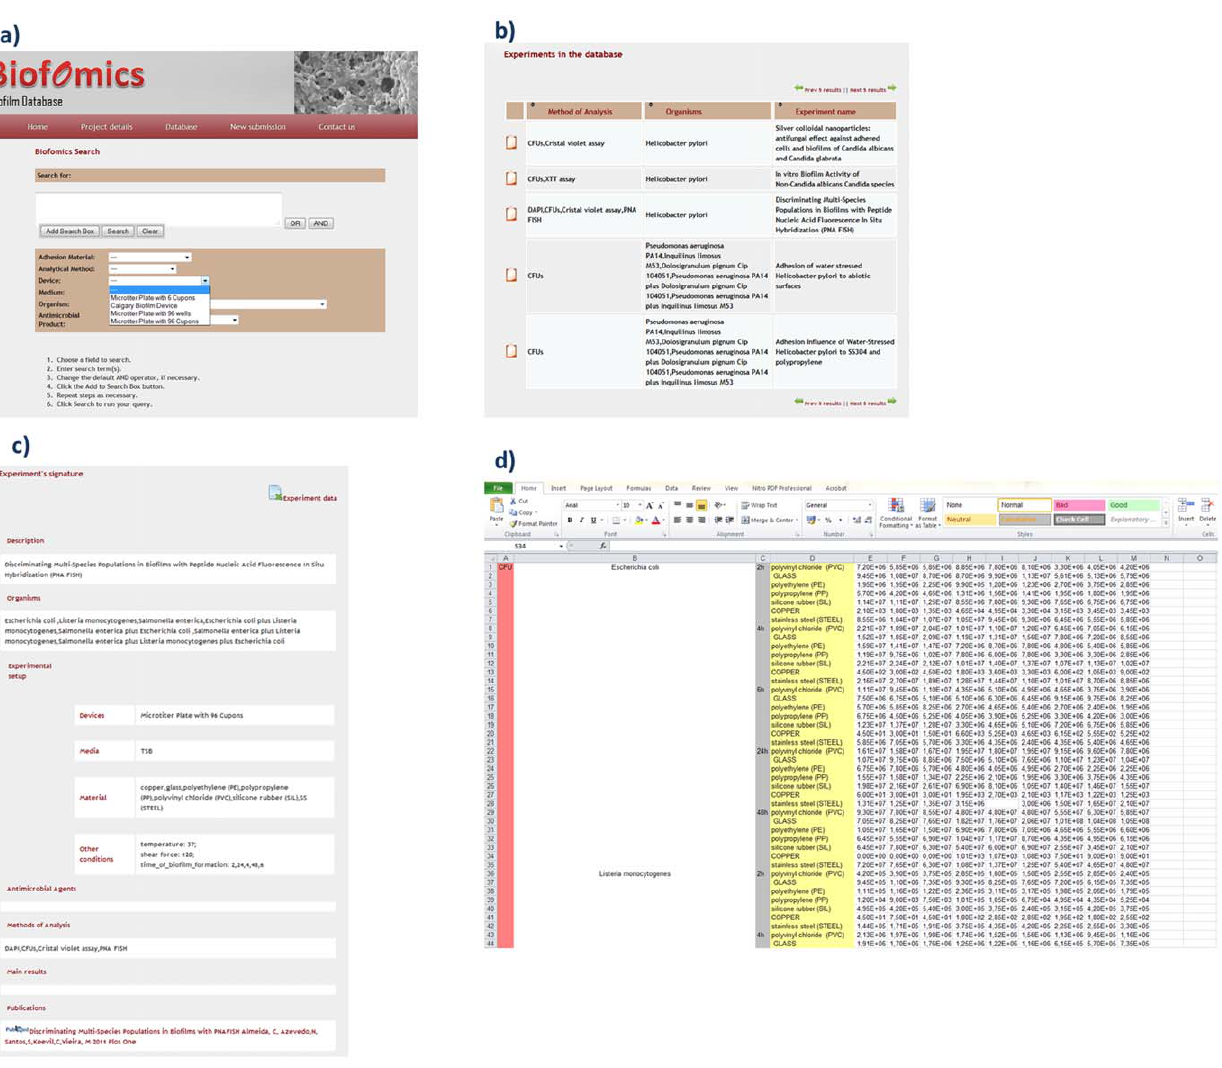
Figure 4. BiofOmics search facility. Researchers can issue searches over biofilm-forming devices, microbial species, growth media, adhesion material and antimicrobial products. Available search terms come from biofilms ontology and report to studies in